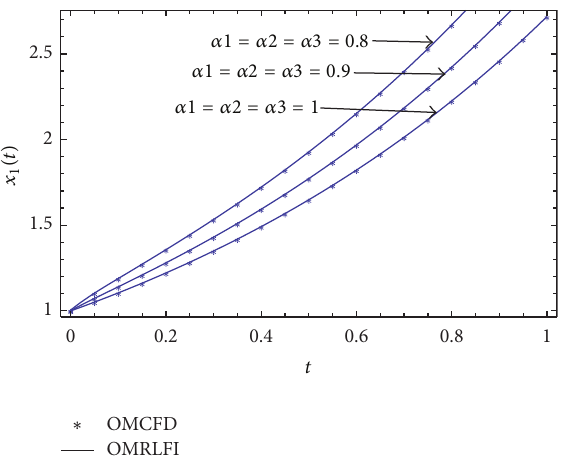
Figure 10: Approximate solutions of 𝑥 2 (𝑡) for 𝑚 = 10 and different values of 𝛼 1 , 𝛼 2 , 𝛼 3 by OMCFD and OMRLFI in Example 14.